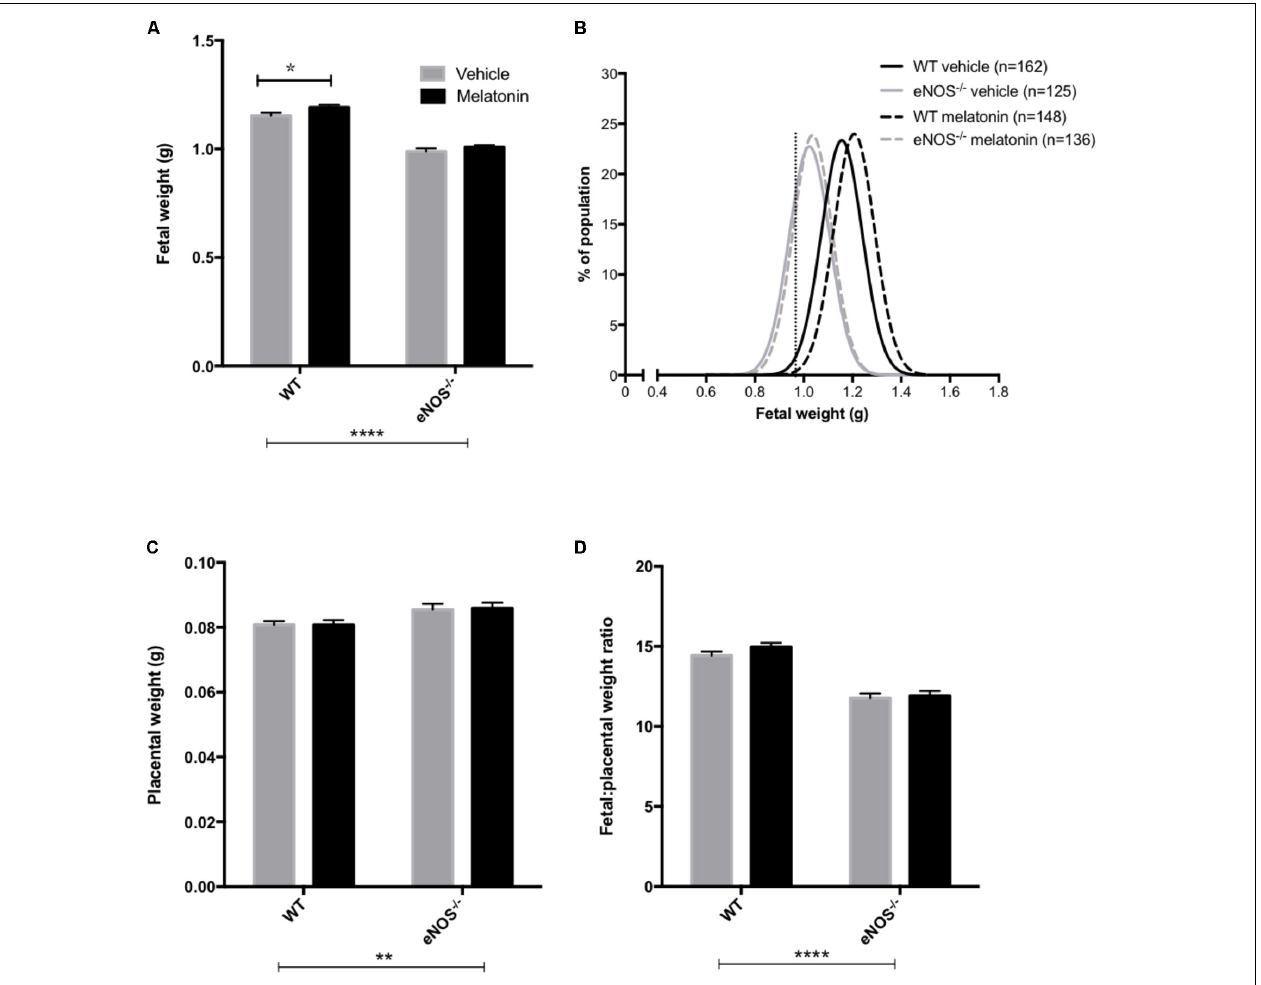
FIGURE 1 | Fetal and placental weights and fetal:placental weight ratio in WT and eNOS - / - mice at embryonic day 18.5. In (A,C,D) , mean + SEM is shown. (B) is a % frequency distribution plot of individual fetal weights with vertical dotted lines denoting the 5th centile (0.96 g, line on left) and 10th centile (1.06 g, line on right) of WT vehicle weights and n = number of fetuses. Number of litters are as follows; WT vehicle N = 21, WT melatonin N = 21, eNOS - / - vehicle N = 18, eNOS - / - melatonin N = 20. ∗ P < 0.05, ∗∗ P < 0.01, ∗∗∗∗ P < 0.0001. Generalized linear mixed models analysis with sequential Sidak post-test.